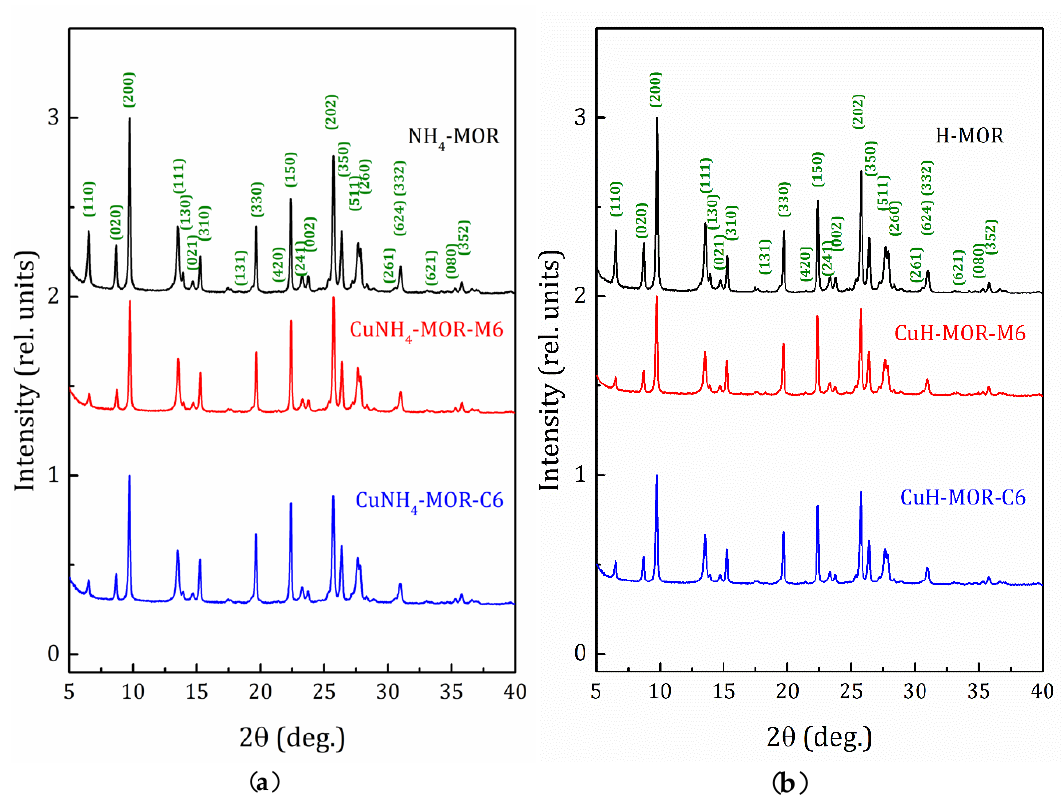
Figure 1. X-ray diffraction (XRD) patterns for the starting and copper-exchanged samples obtained after six MW-assisted and conventional procedures; ( a ) -ammonia form and ( b ) -proton form.